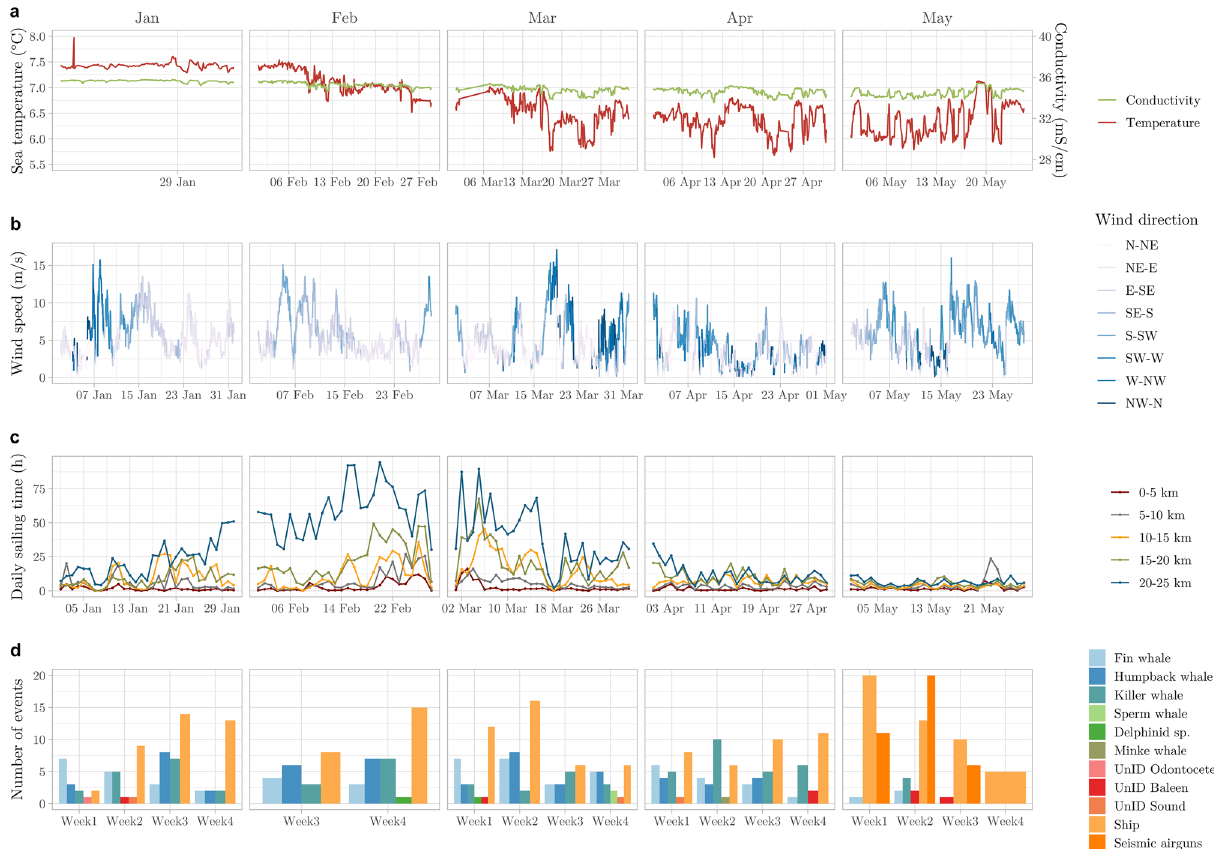
Figure 2. Overview of physical and acoustic properties of the sampling period. ( a ) Temperature and conductivity; ( b ) wind speed recorded by a land-based weather station; ( c ) cumulative sailing time across all ship types per distance radius; ( d ) detection events for each week of the analyzed